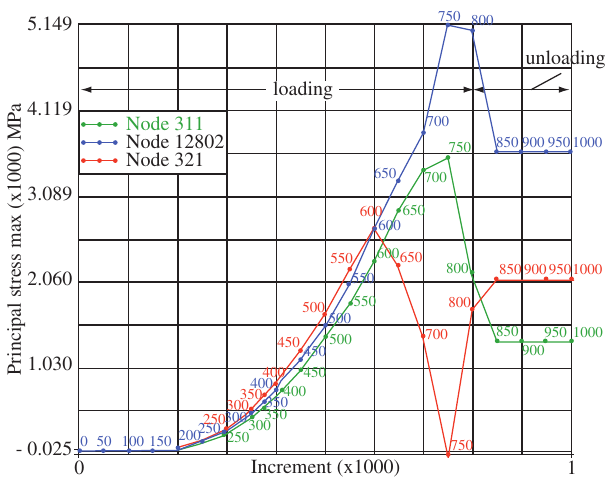
Figure 6. Evolution of the highest principal stress during the simulation of three selected points (see Figure